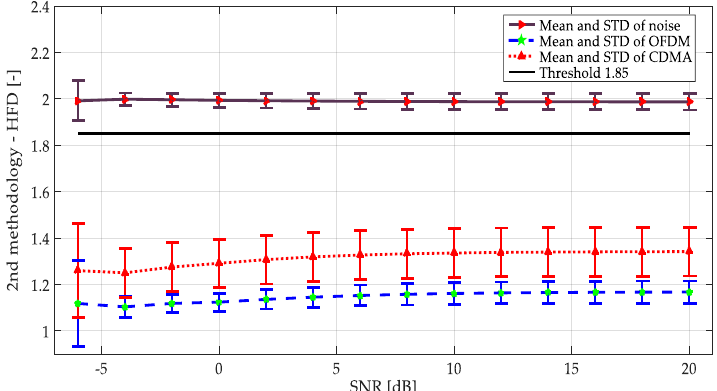
Figure 17. Mean and standard deviation for noise and simulated symbols (OFDM and NRZ-CDMA) applying the second methodology.